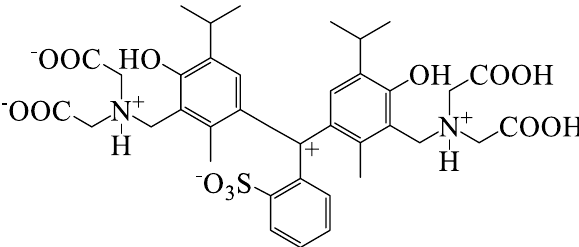
Figure 1. Molecular structure for the 6-protonated form of